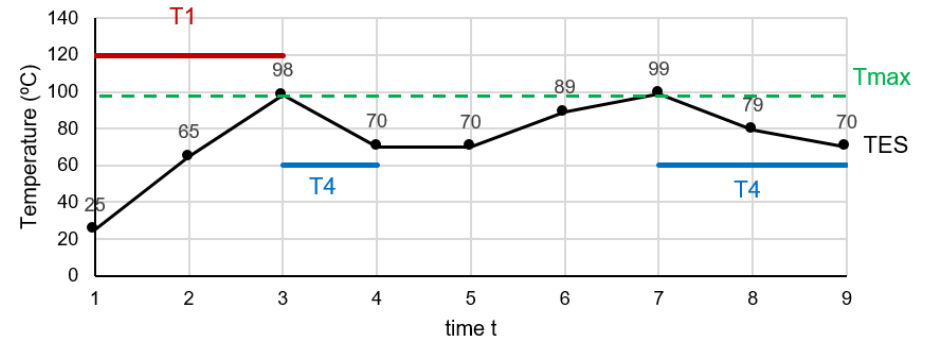
Figure 7. Scenario (b) TES1 temperature profile.